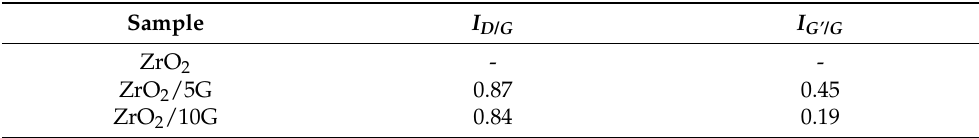
Table 2. Experimental Raman ratio of intensities of D to G peaks expresses the crystallinity- induced graphene. Sample I D/G I